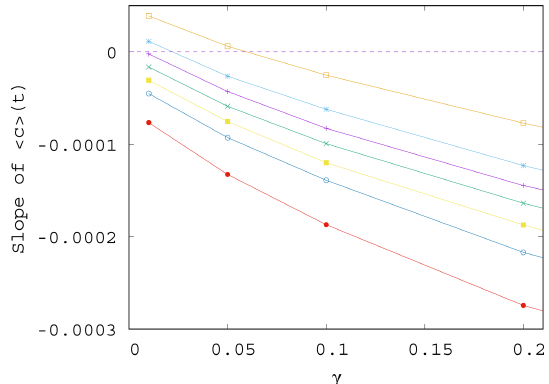
Figure 7. Slope S of the ensemble average of the phytoplankton concentration, < c > , for t > 0 as γ is varied; data shown for var- ious values of α , from top to bottom, α = 0 . 2, 0.1, 0.05, 0, − 0 . 05, − 0 . 1, and − 0 .